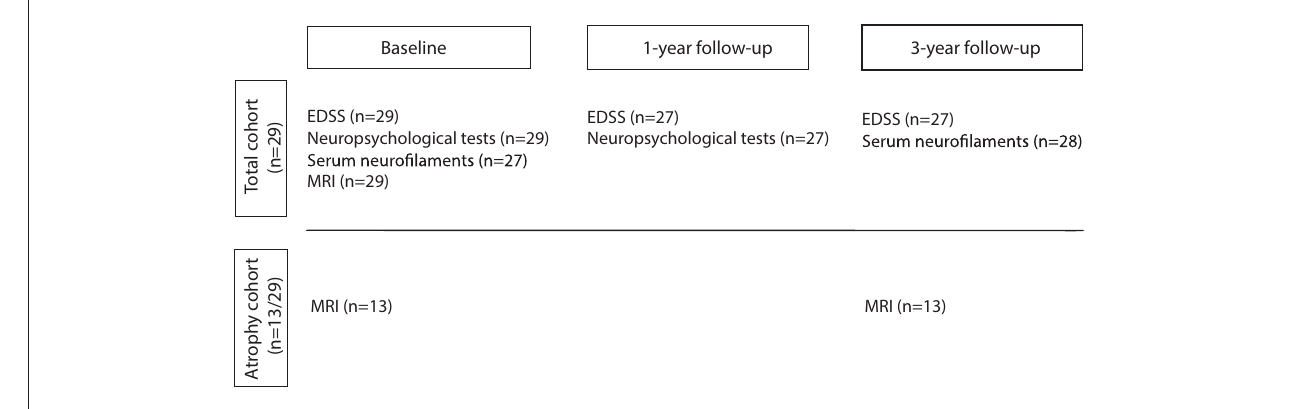
FIGURE 2 | The flowchart provides a temporal overview of the examinations of the study cohort. Total cohort ( n = 29) underwent examinations including Expanded Disability Status Scale (EDSS), Timed 25-Foot Walk Test (T25FW), Nine-Hole-Peg-Test (9-HPT), Symbol Digit Modality Test (SDMT), a blood draw for serum neurofilament light chain (sNfL), and 7T MR imaging (SWI, FLAIR, and MP2RAGE) according to the time point indicated above. Lateral ventricles and subcortical structures were measured only in the so-called atrophy cohort of 13 patients as they were scanned at both time points within 1 month, which increases data homogeneity. Two RRMS patients dropped out before 1-year follow-up examination due to time constraints and a move abroad.